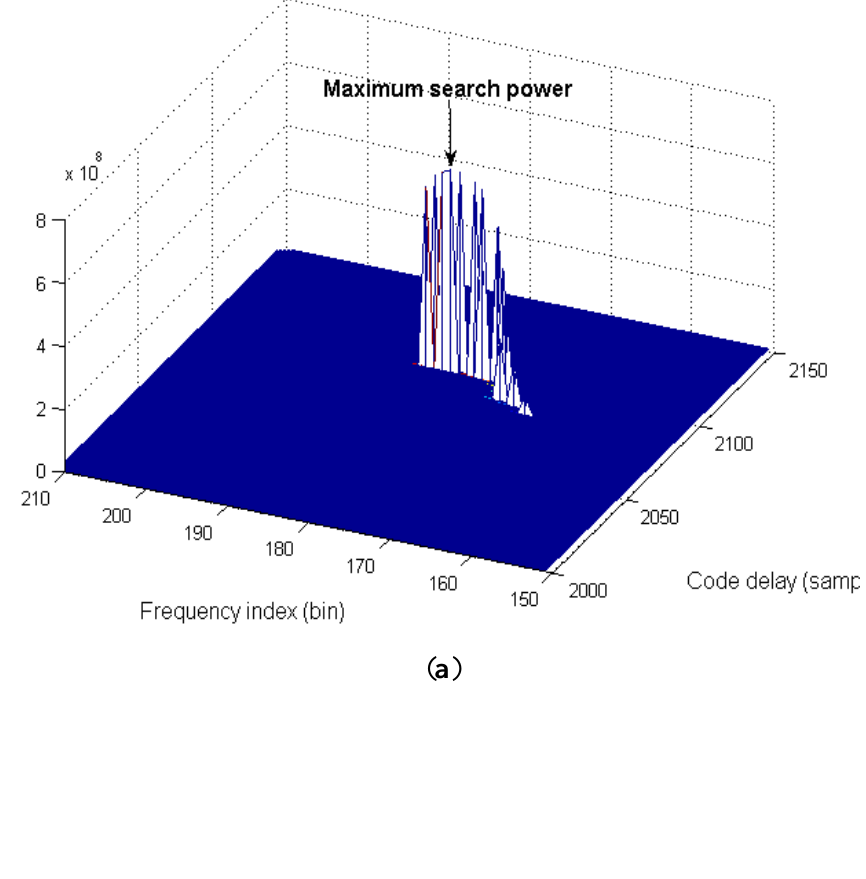
Figure 5. Signal acquisition results of proposed method; ( a ) C/A-code; ( b ) BOC-code; ( c )